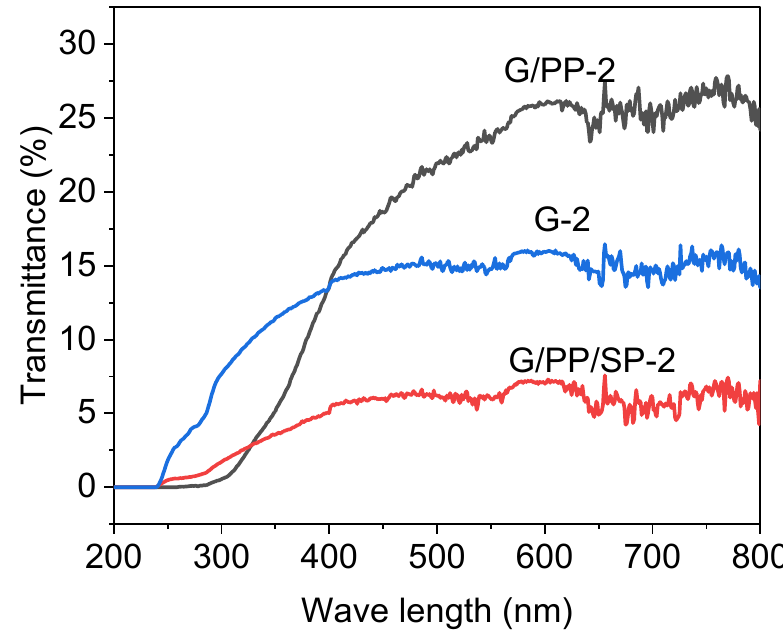
Figure 3. Transmittance spectra of edible films (black line indicates G/PP-2 film, blue line indicates G-2 film, and red line indicates G/PP/SP-2 film).